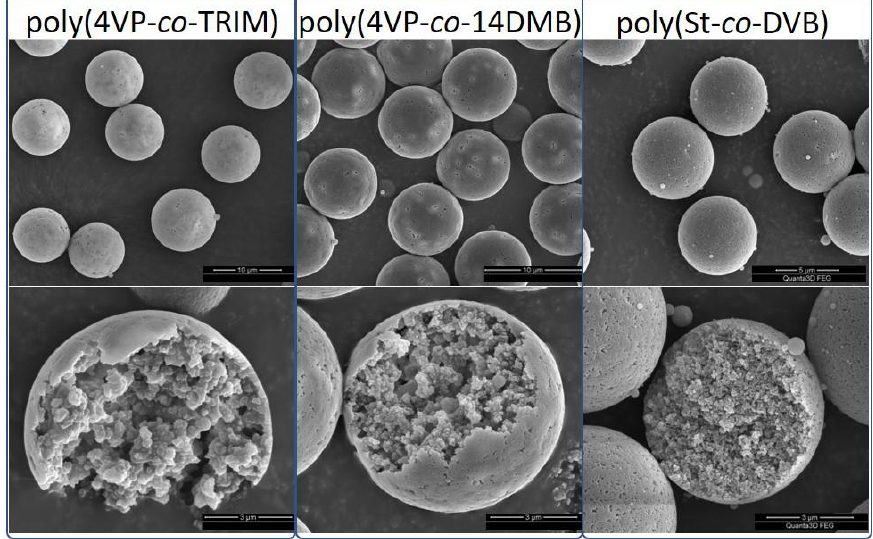
Figure 4. SEM images of 4VP copolymers and poly(St- co -DVB).